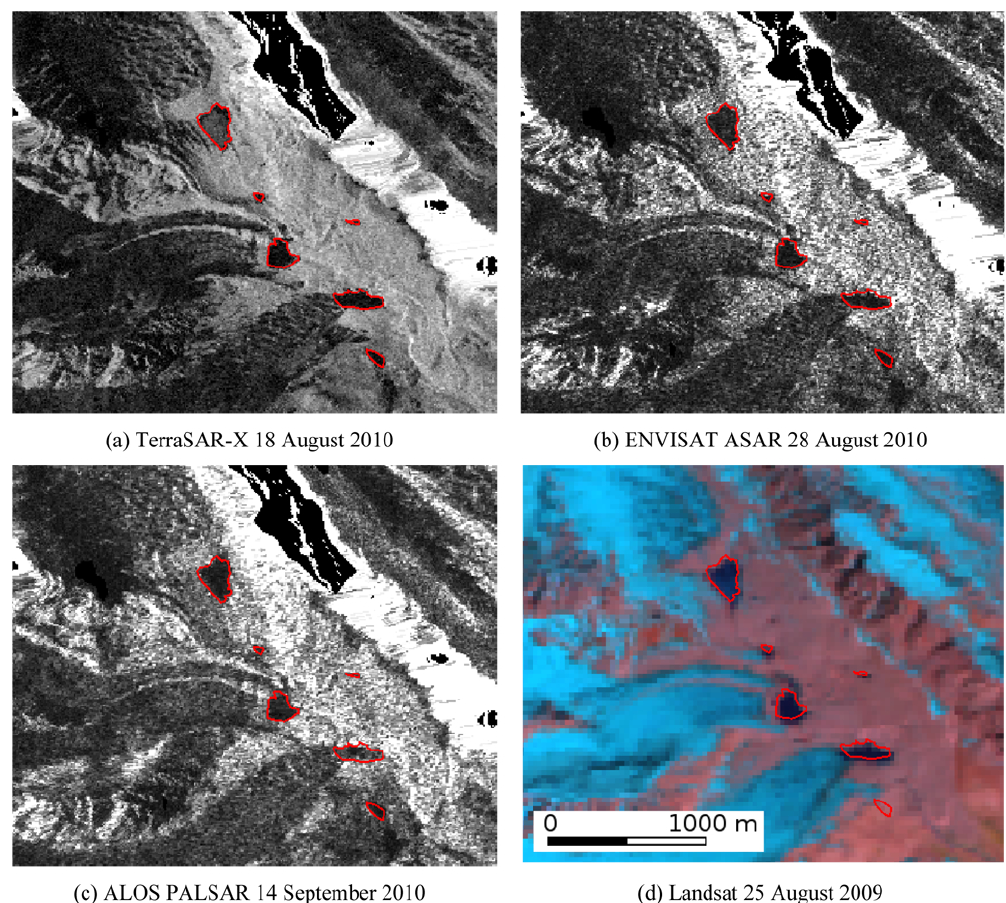
Fig. 6. Terrain-corrected geocoded TerraSAR-X, ENVISAT ASAR and ALOS PALSAR images for the summer of 2010 for glacial lakes with an extension of a few hundred of meters located in the upper Shadzuddara area in Tajikistan. The outlines of the lakes, determined in the TerraSAR-X intensity image of the summer of 2009, are shown in red. Layover and shadow are masked in black. A Landsat 5 TM image of the summer of 2009 is presented for